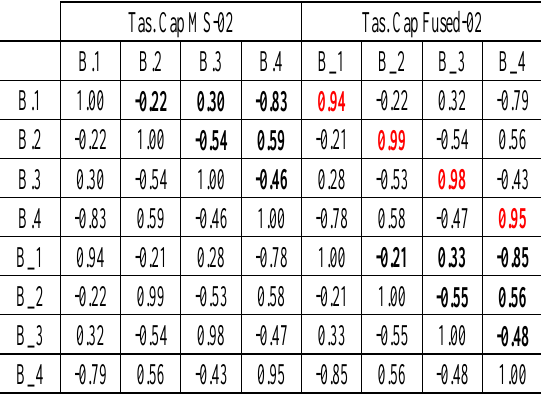
Table 6. Correlation matrix between the bands (B) of MS-02 image (B.1-B.4) and fused image-02 (B_1-B_4).